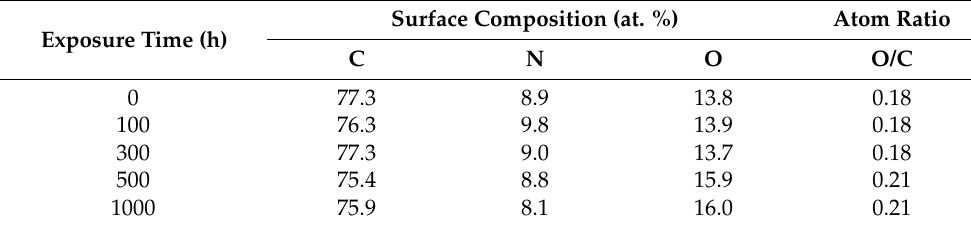
Table 2. Relative content of elements before and after ozone exposure.